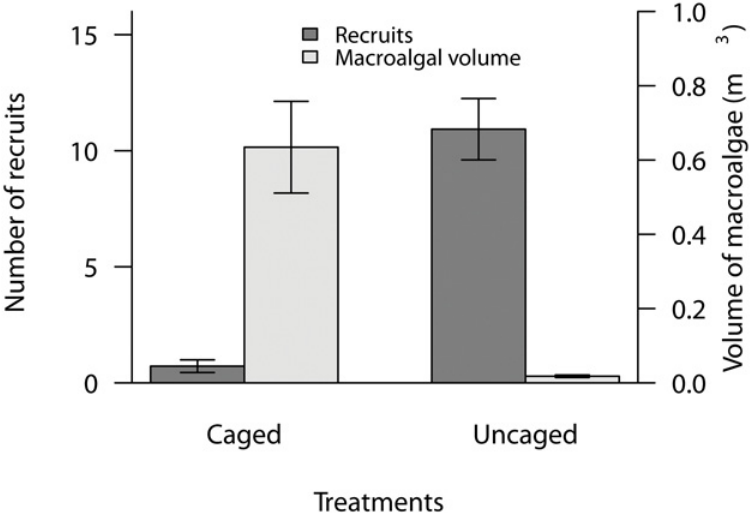
Fig 1. Average volume of macroalgae and number of coral recruits on settlement tiles in the caged and uncaged treatments in the larval settlement experiment.